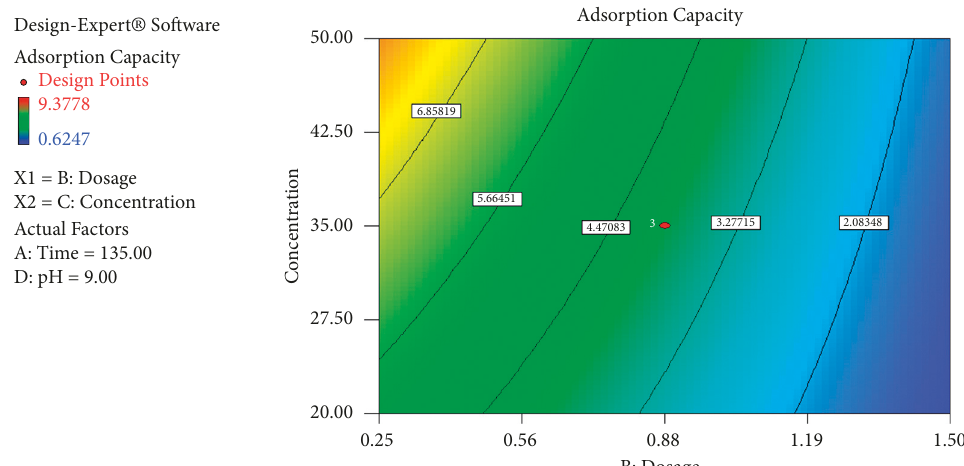
Figure 3: Contour plot for the interaction between adsorbent dosage and initial concentration on adsorption capacity of MB